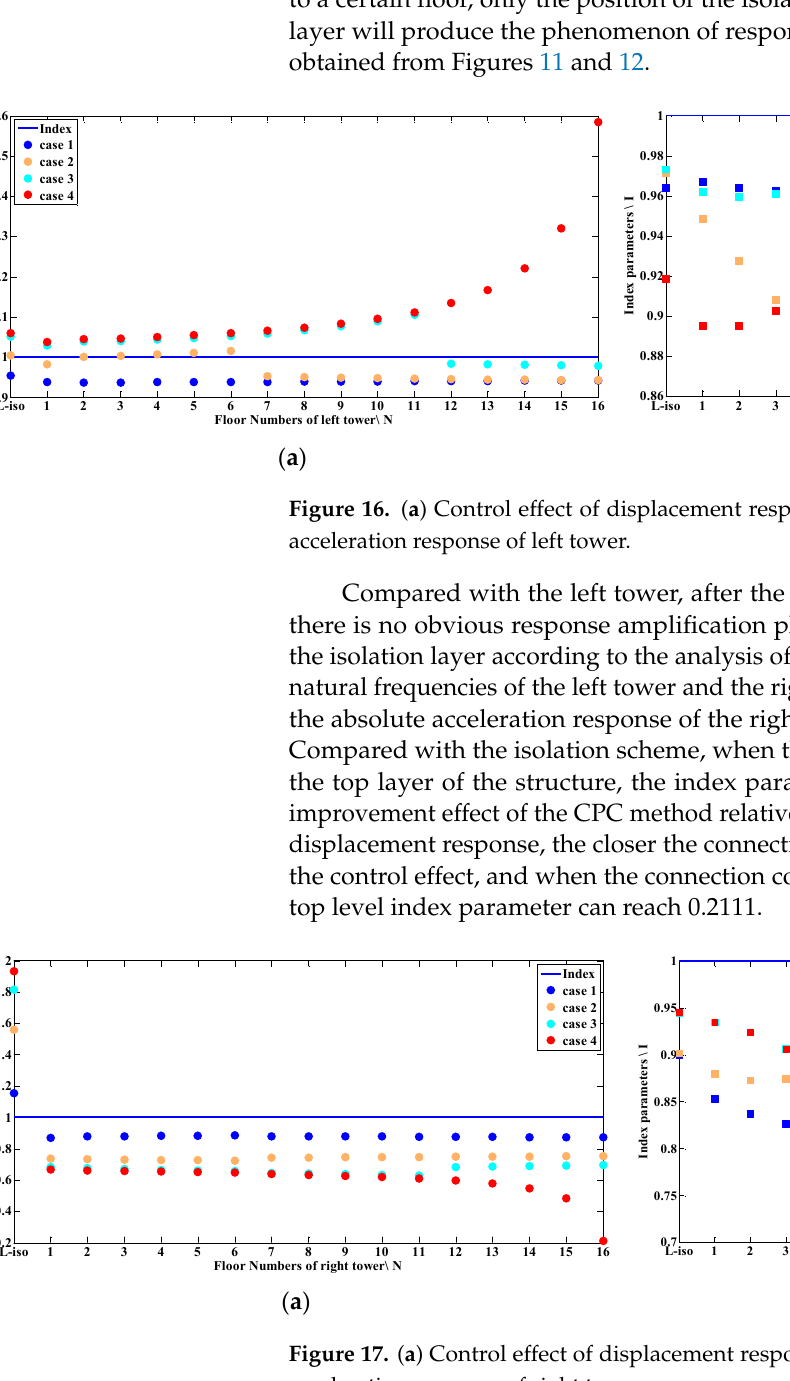
( b ) Figure 15. ( a ) Control effect of displacement response of podium; ( b ) control effect of absolute ac-